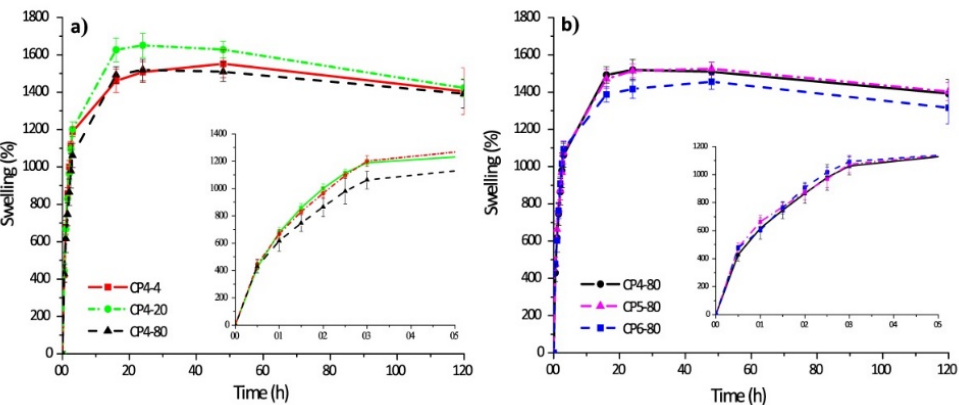
Figure 6. Swelling behavior of polymer hydrogels: chitosan–PVA hydrogels prepared with four cycles of freeze–thawing ( a ); chitosan–PVA hydrogels obtained at − 80 ◦ C with different numbers of freeze–thawing ( b ). In the sample abbreviation, the first number after “CP” indicates the quantity of freeze–thawing cycles, the second one indicates the temperature of freezing. Reproduced from [35], with permission from JoVE, 2021.